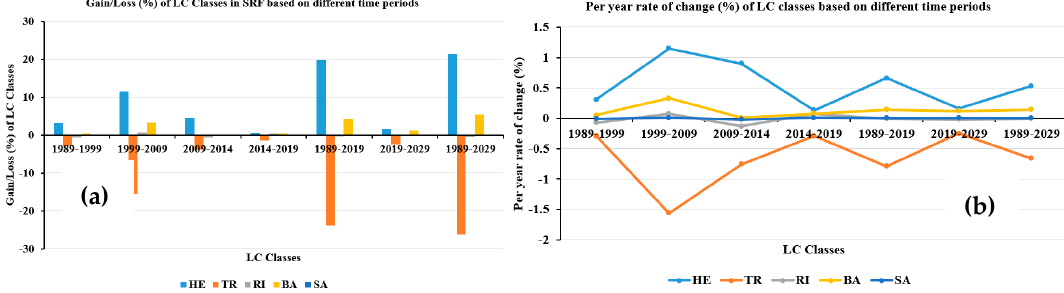
Figure 6. Gain and loss (%) and per year rate of change (%) distribution of different LC classes in SRF: ( a ) Gain and loss (%) of LC classes during different time periods in 1989–2029, ( b ) per year rate of change (%) of LC classes based on similar time periods.